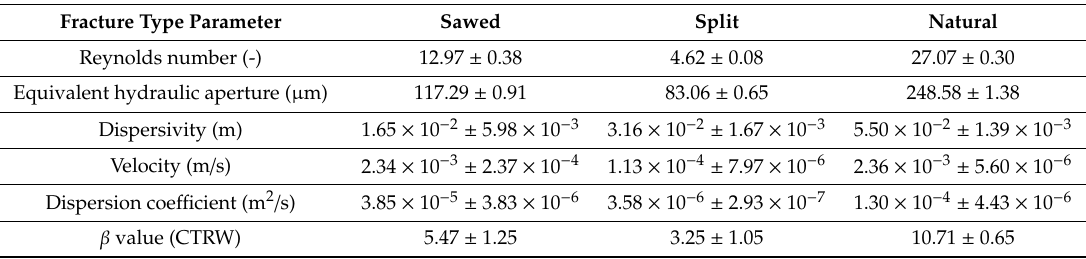
Table 1. Hydraulic, transport and fitting parameters estimated from the Darcy and tracer experiments as well as the CTRW fits with standard deviation values.